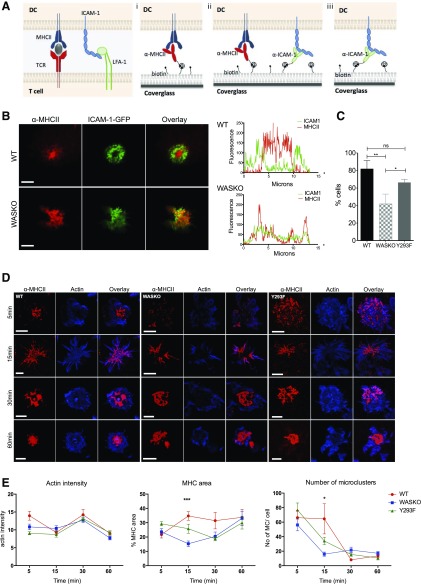
The development of a novel imaging system of the DC synapse.(A) Three different lipid bilayer compositions were designed to mimic a DC:T cell synapse. A biotinylated α-MHC II-Cy5-conjugated antibody was incorporated to replace TCR interaction (Fig. 2). Alternatively, both α-MHC II-Cy5 and α-ICAM-1 antibodies were added to replicate adhesion forces (A and E). α-ICAM-1 alone was used in D. (B) ICAM-1-GFP-expressing DCs interacting with an α-MHC II bilayer were fixed after 20 min and imaged. Original scale bars, 5 μm. Fluorescence intensity of ICAM-1-GFP and MHC II-Cy5 is plotted along the cell diameter, showing differential distribution in WT and WASKO DC. (C) Number of cells exhibiting radial symmetry, as a percentage of cells interacting with the α-MHC II bilayer. A minimum of 30 cells per strain was analyzed. Cells with radial symmetry were defined as having at least 3 different diameter cross-sections showing plots similar to WT DC in B. *P = 0.0232; **P = 0.0092; ns, P = 0.0572. (D) WT, WASKO, and Y293F DCs interacting with the α-MHC II-Cy5 (red) bilayer were fixed and stained with phalloidin (blue). Original scale bars, 5 μm. (E) Three parameters were measured by use of ImageJ “Measure” and “Analyze particles” functions in cells interacting with an α-MHC II-Cy5 bilayer: average actin intensity across the contact; MHC II area as a percentage of the total contact area (actin); and number of peripheral microclusters (MC) per cell (size < 600 nm2). Means and sem are shown for a minimum of 25 cells per condition analyzed in 2 experiments. ***P(WT + WASKO) < 0.0001, P(WASKO + Y293F) = 0.0061, P(WT + Y293F) = 0.0664; *P(WT + WASKO) = 0.0113, P(WASKO + Y293F) = 0.0084, P(WT + Y293F) = 0.0769.